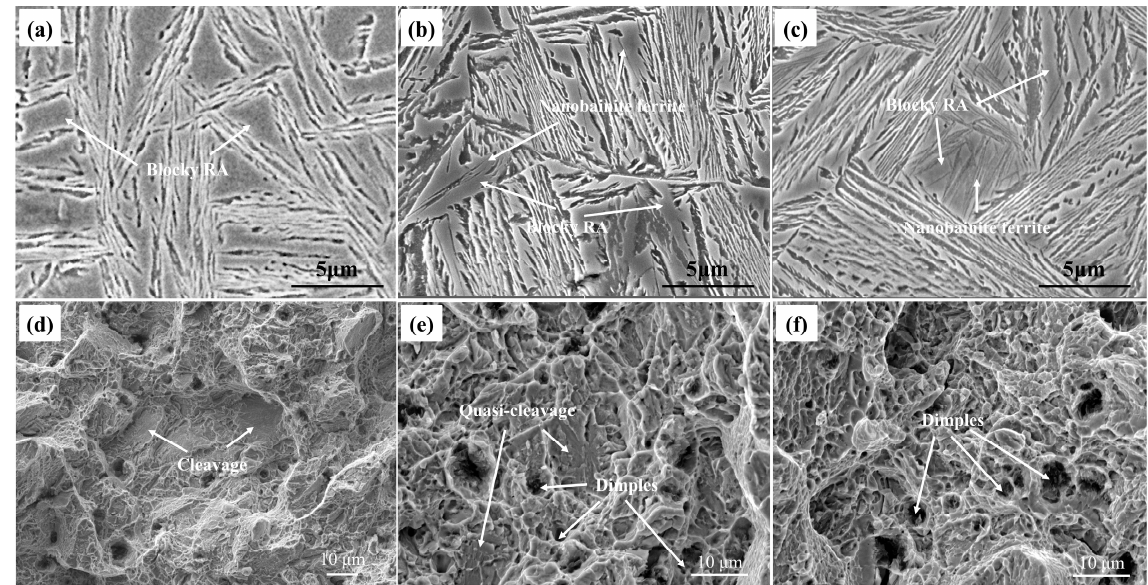
Figure 5. SEM of microstructure and fracture: ( a , d ): BA sample; ( b , e ): BAQ sample; ( c , f ): BAP sample.